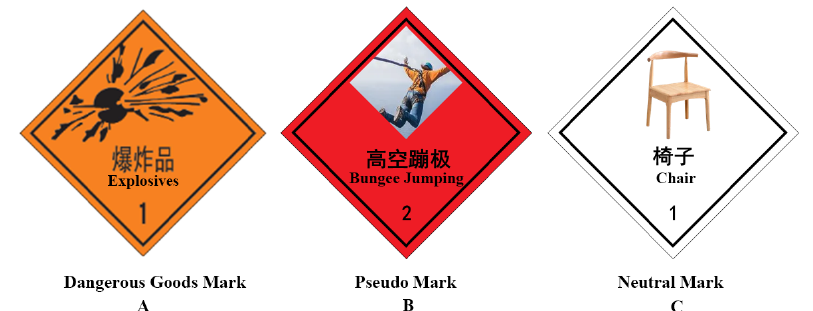
Figure 1. Examples of three types of signs: ( A ) a dangerous goods mark indicating “Beware of explosives”; ( B ) a pseudo-mark indicating “Bungee jumping is risky”; ( C ) a neutral mark.